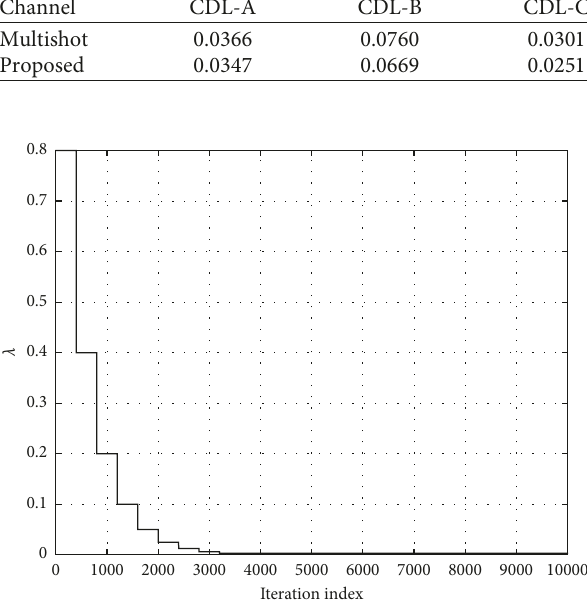
Figure 3: Regularization parameter λ vs. iteration number.